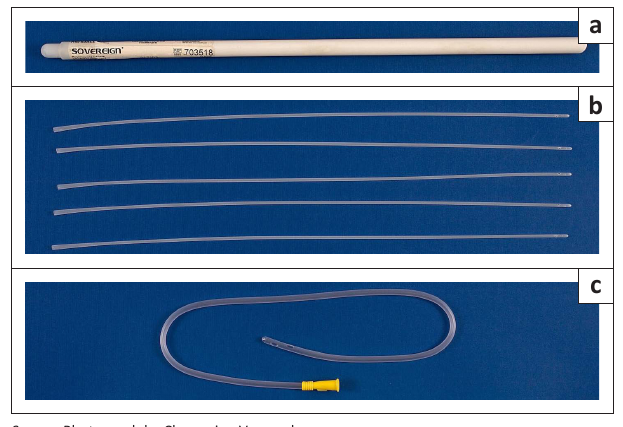
FIGURE 3: Examples of the (a) container for the catheters, (b) catheters and (c) tubes used in this investigation. For the collection of most of the urine samples,